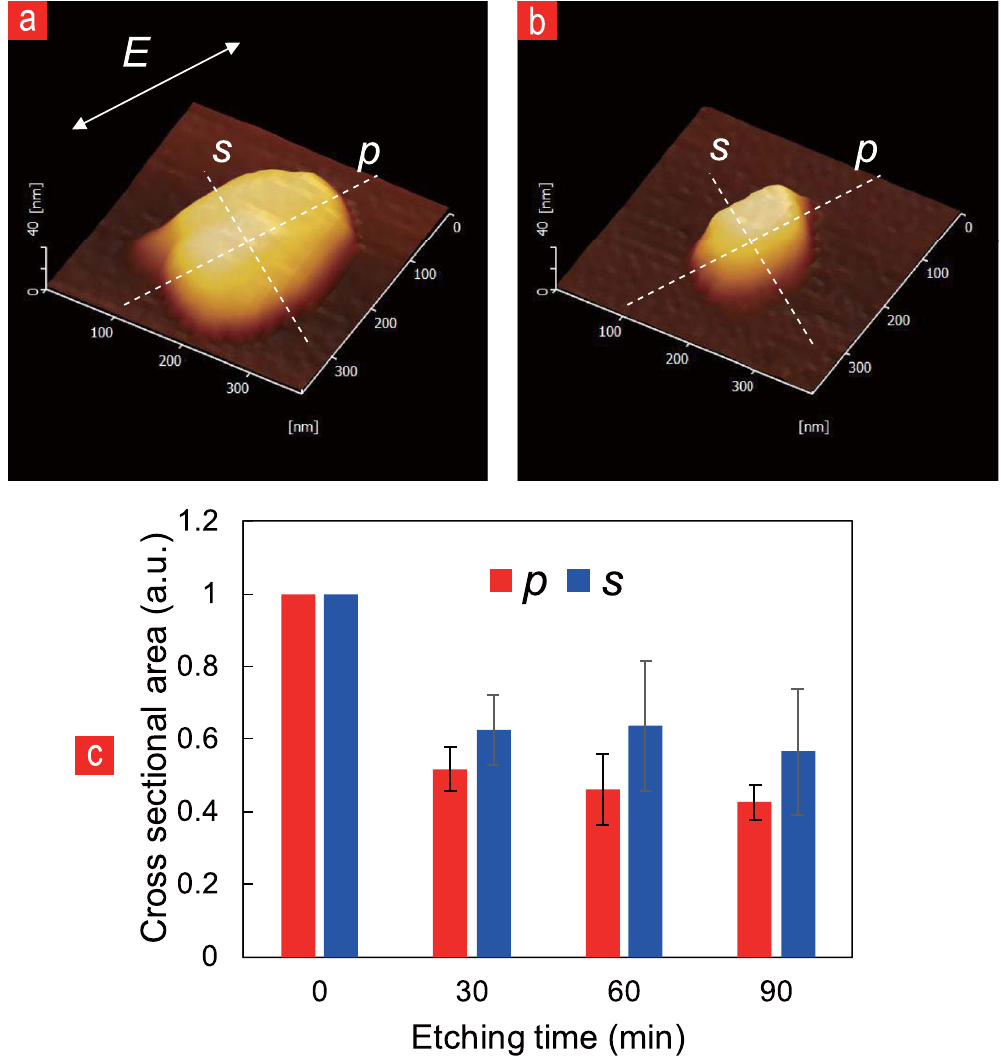
Figure 2. AFM images of the nanodiamonds, comparing their size before ( a ) and after 90 min ( b ) of He-Cd laser illumination. The comparison in size has been further examined through AFM in ( c ) by comparing the cross-sectional area of the nanodiamonds along the presumed parallel laser polarization axis ( p -axis) and the presumed perpendicular laser polarization axis ( s -axis), showing a general decrease in the cross-sectional area over illumination